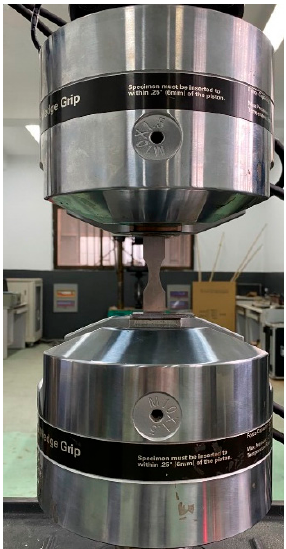
Figure 2. The photograph of the fatigue testing on GH3039 superalloy specimen.